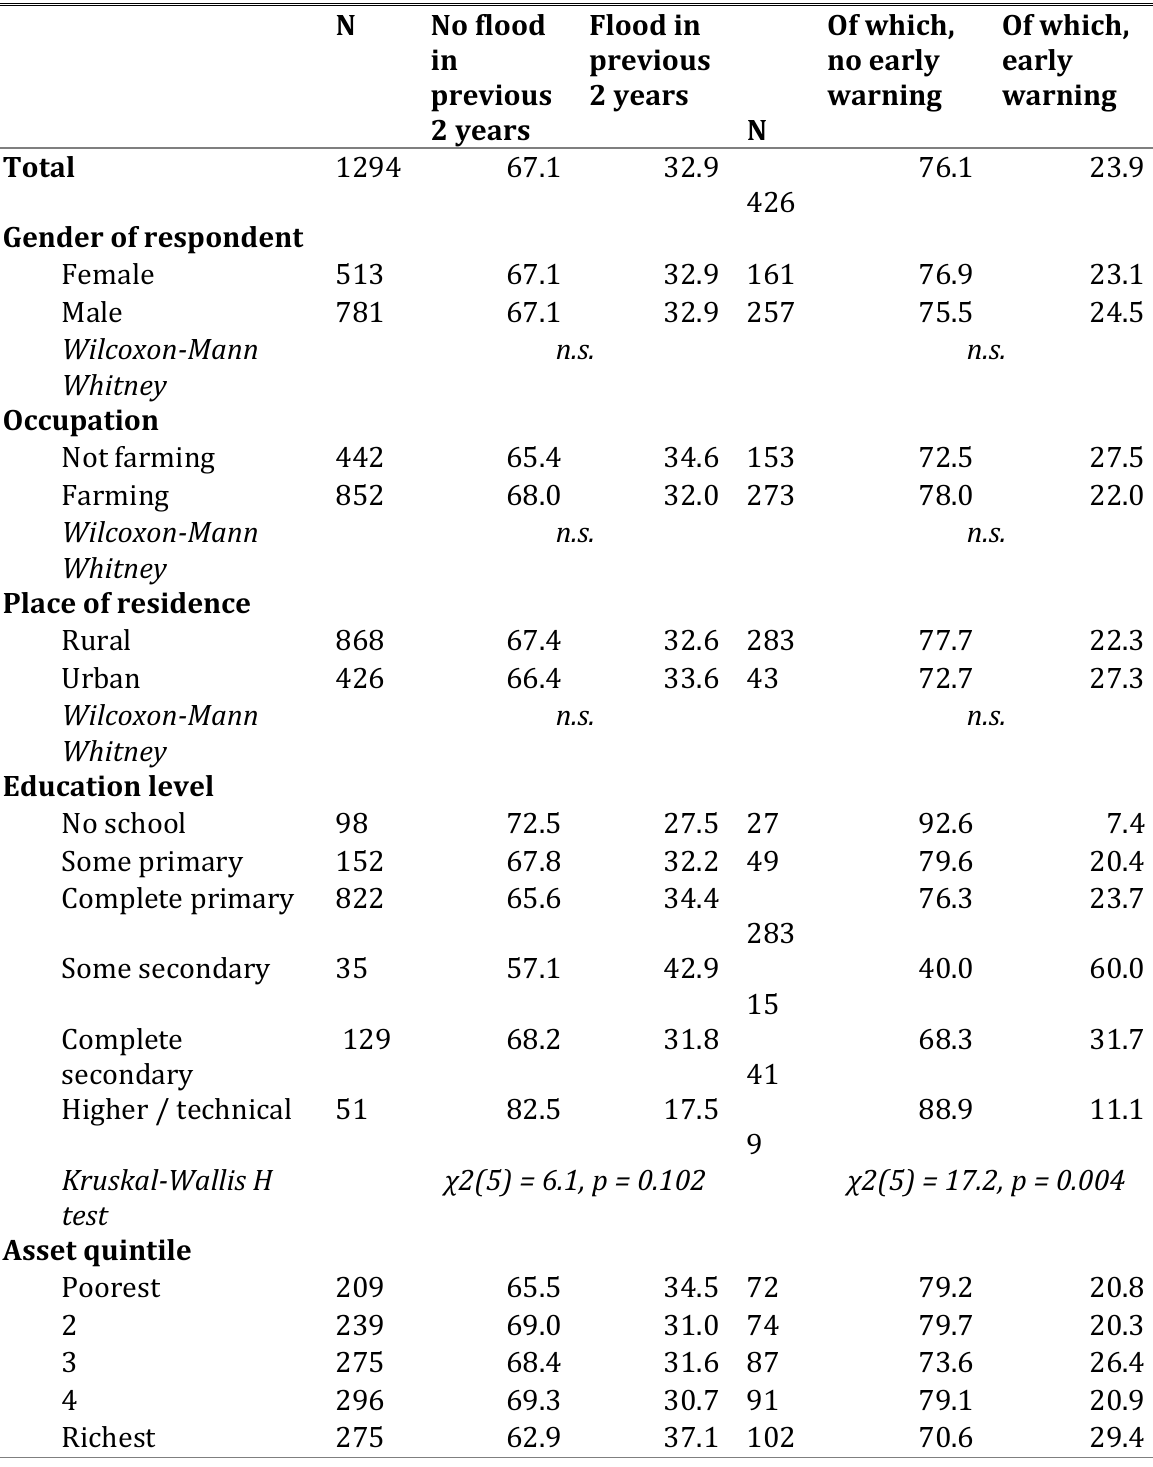
Table A1.1. Respondents’ experience of flood in previous two years and whether they knew of it in